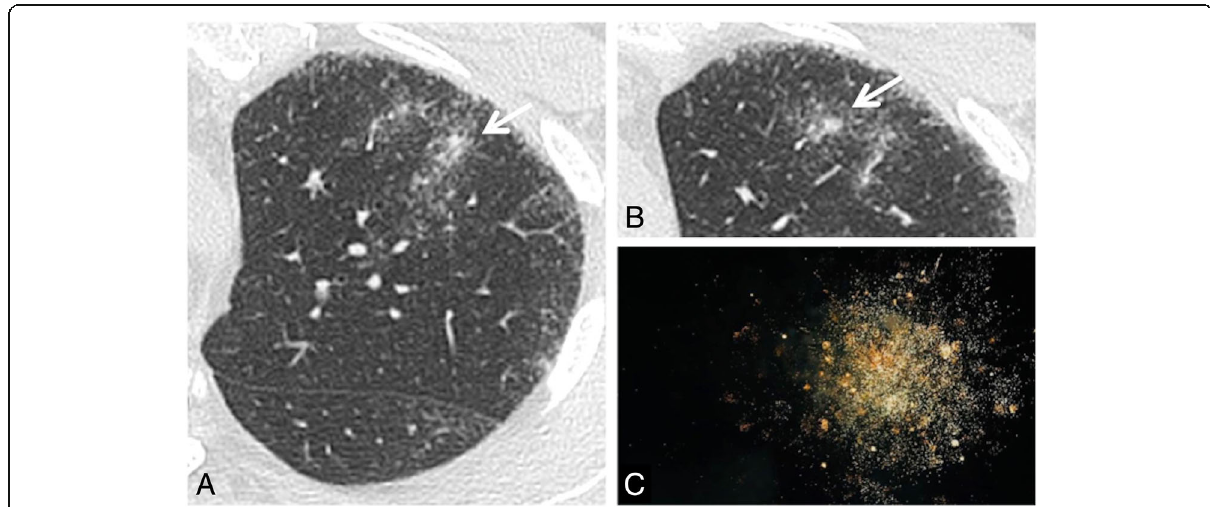
Fig. 15 Galaxy sign. The figure shows two ill-defined nodular consolidations in the left upper lobe, surrounded by satellite small nodules (white arrows in a and b ). The presence of small nodules — close to the central nodular areas — resemble the appearance of a “ galaxy ” (evocated in the embedded figure c ). This galaxy appearance is a typical finding of sarcoidosis